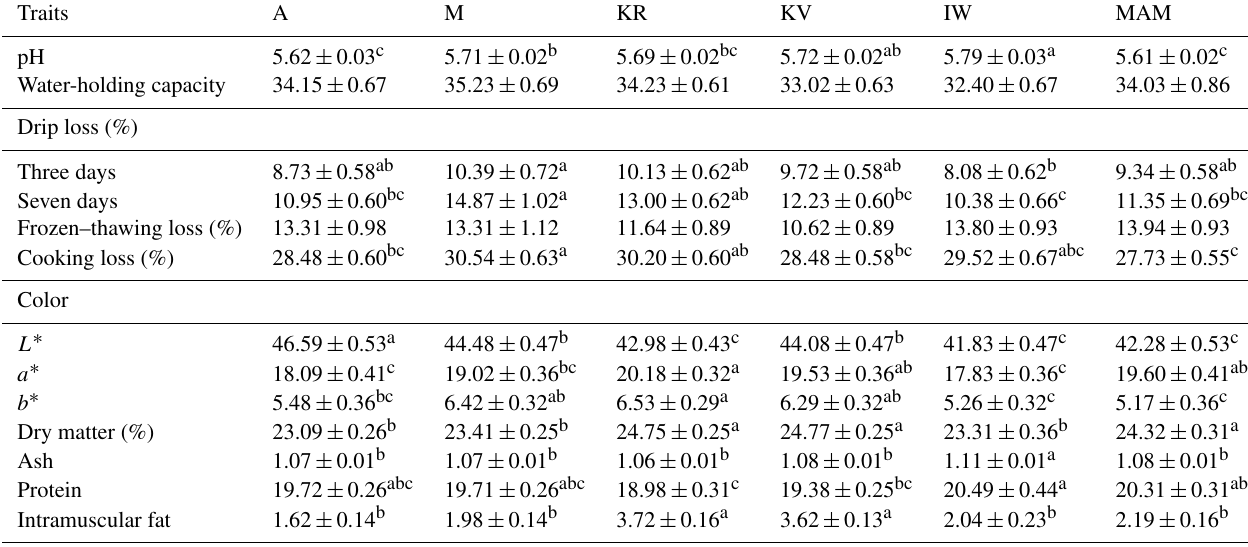
Table 2. Meat quality parameters and chemical composition of longissimus dorsi muscle from male lambs born to Turkish indigenous sheep breeds.